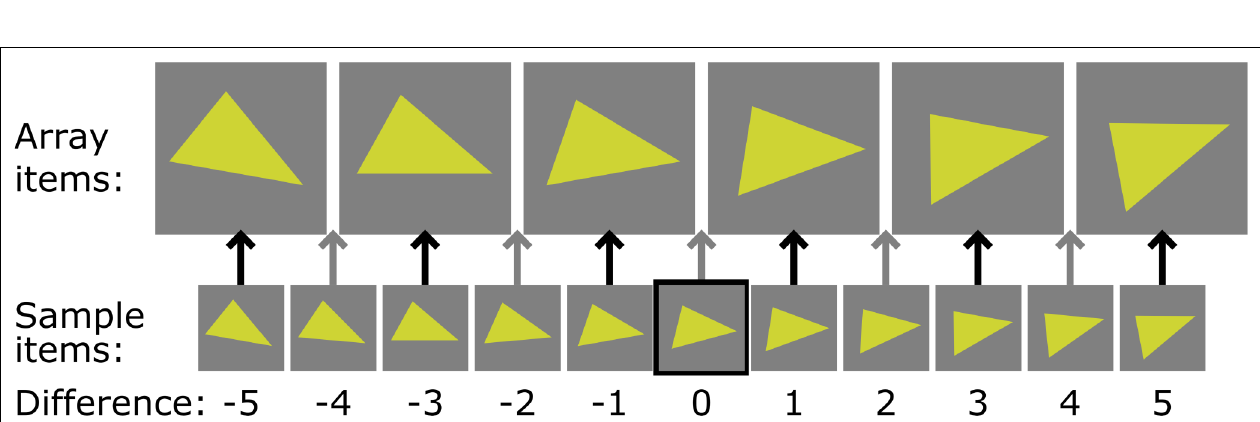
FIGURE 3 | Trial sequence for delayed condition. From left to right: fi xation; sample presentation (2s); sample masked ( ∼ 4.5s); fi xation ( ∼ 1.5s); search array presentation (6s); response screen.